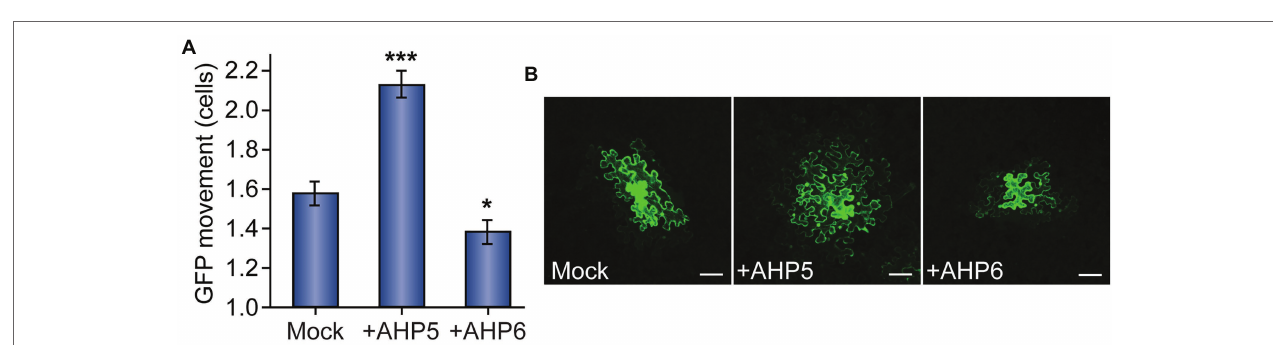
FIGURE 3 | Cytokinin phosphorelay proteins AHP5 and AHP6 regulate PD transport. (A) Compared to mock-infiltrated plants, GFP movement from transformed cells significantly increased in leaves overexpressing AHP5 ( n = 141, *** p < 0.001; error bars indicate SEM). Overexpressing the negative regulator of cytokinin signaling, AHP6 , had the opposite effect, decreasing PD transport in leaves ( n = 161, * p < 0.05; error bars indicate SEM). (B) Representative confocal images of transformed N. benthamiana cells demonstrate the difference in GFP movement between conditions. GFP moved 1–3 cells beyond the transformed cell in mock- treated leaves. In leaves overexpressing AHP5 , GFP regularly moved more than two cells and often as many as four cells from the transformed cell. In leaves overexpressing AHP6 , GFP movement was confined to one, or sometimes two, cell(s) beyond the transformed cell. The fourth leaf from 4-to-5-week-old N. benthamiana plants was used for each experiment; white scale bars = 100 μ